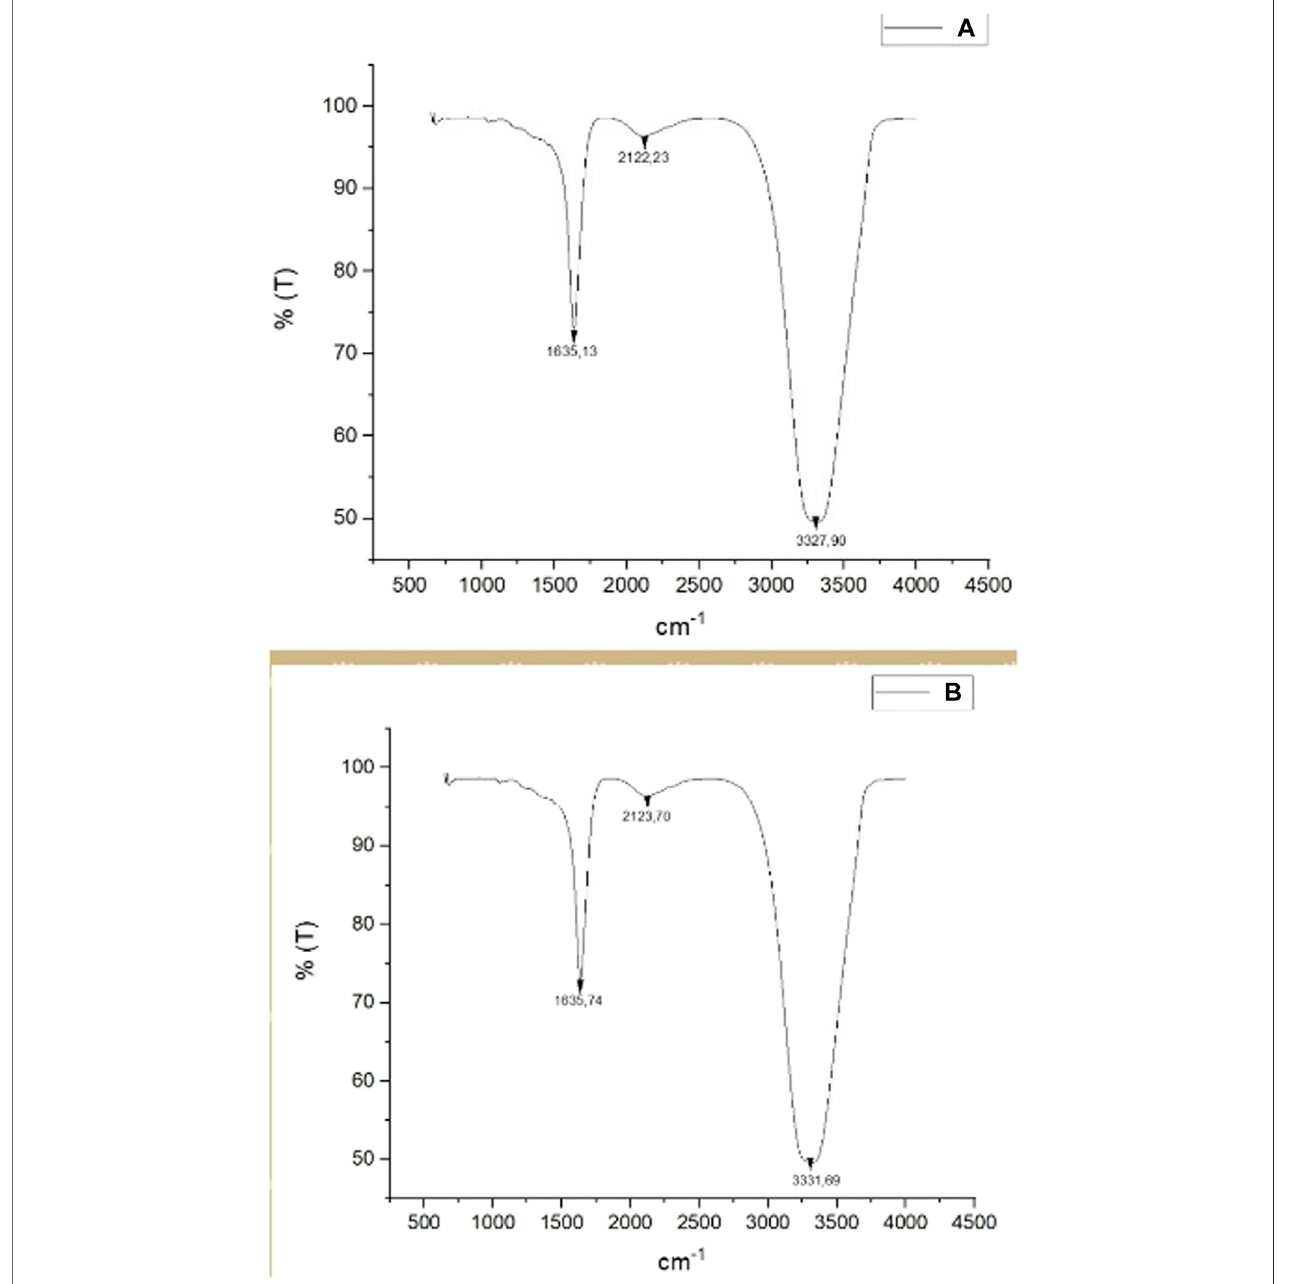
FIGURE 5 | (A) FT-IR spectra data of CA leaf extract. (B) FT-IR spectra data of synthesized CA-AgNPs.